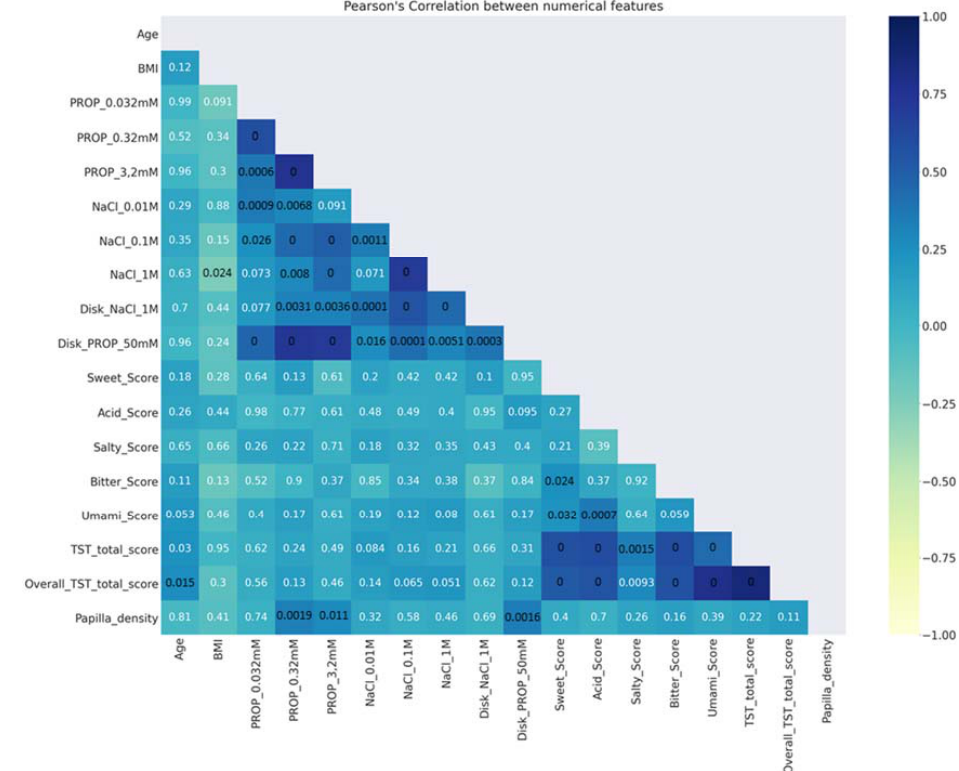
Figure 2. Linear correlation analysis between the numerical features in the dataset. The bar color on the right ‐ hand side on the Y ‐ axis represents the value of linear correlation between features, with − 1 indicating total negative linear correlation, 0 indicating no linear correlation, and 1 indicating total positive linear correlation. p ‐ Values are indicated inside each square: significant values in black; non ‐ significant values in white.